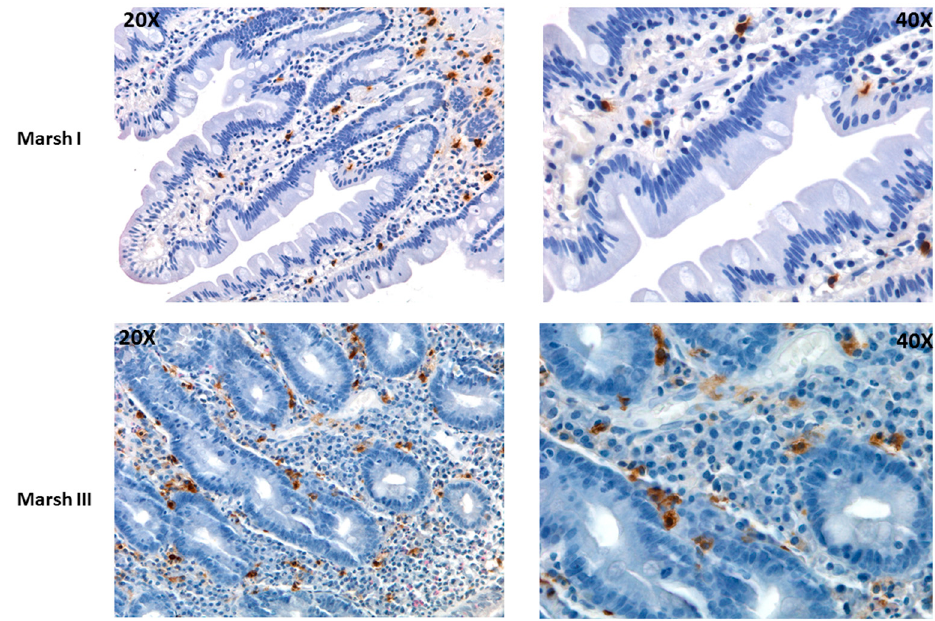
Figure 2. Mast cell accumulation in Coeliac Disease patients increases with the extent of histological damage. Immunohistochemical staining for tryptase in duodenal specimens of two patients with Marsh 1 and Marsh 3 scores. Staining is shown at 20 × (left side) and 40 × magnifications (right side). Images were kindly provided by prof. Claudio Tripodo and Dr. Beatrice Belmonte.